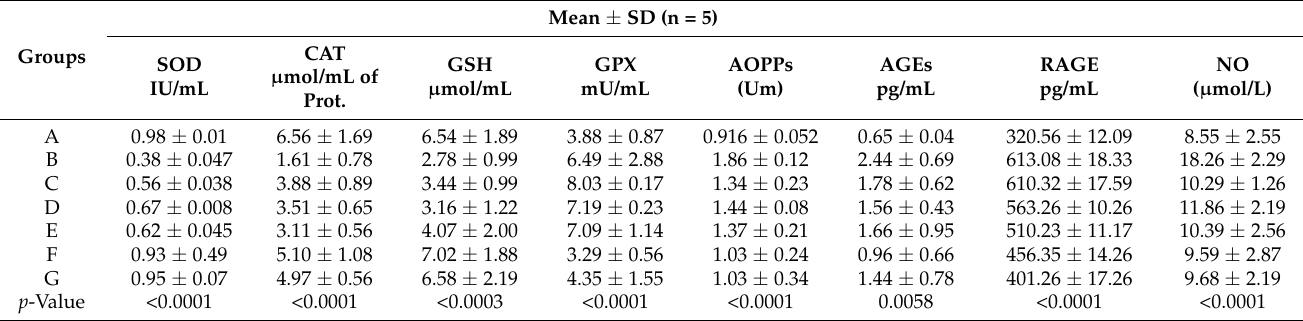
Table 3. Circulatory Stress Markers Profile Of LPS Induced Multiple Sclerotic Wistar